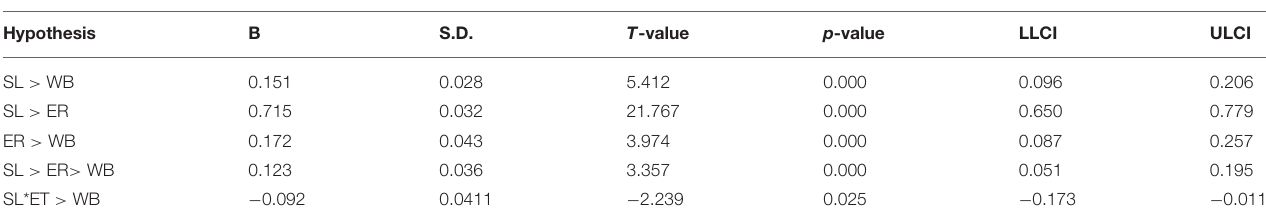
The * symbol indicates the interaction of SL with